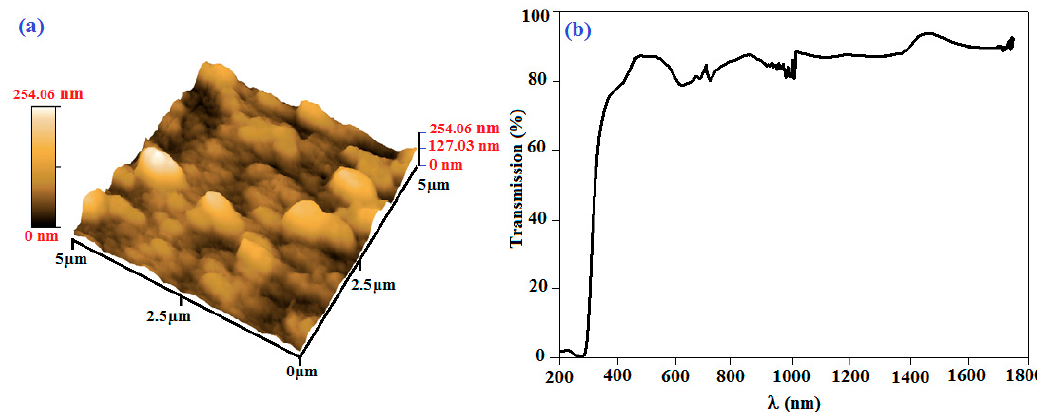
Figure 5. ( a ) 3D AFM image and ( b ) variation of transmission as function of wavelength for PdPc thin films grown by vacuum thermal evaporation technique on ITO/glass substrate.